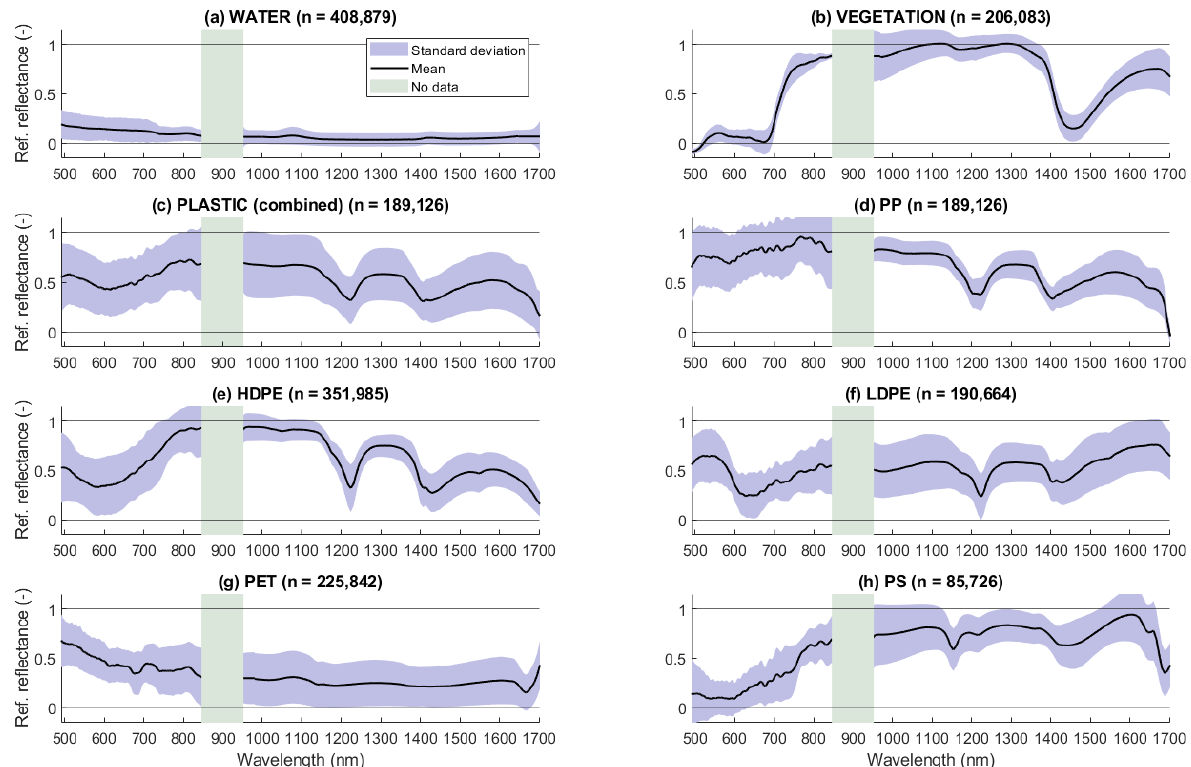
Figure 4. Normalised spectral signatures of the eight classes ( a – h ). The spectral signatures were calculated separately for both cameras and scaled to match the reflectance values before and after the ‘no data’ zone. The scaling caused reflectance values to appear outside of the 0–1 range, which only occurs in this figure and not in the data used in subsequent analyses.